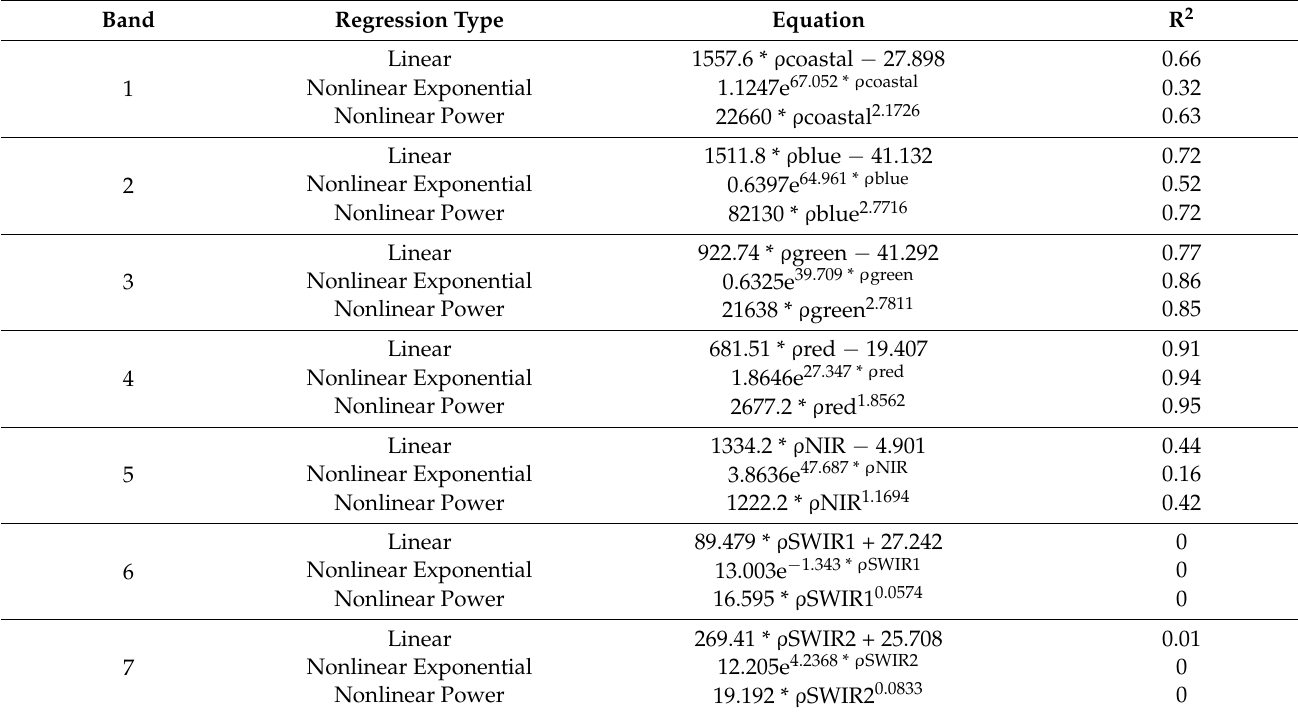
Table 3. Linear, exponential, and power regression equations obtained by comparing in situ turbidity measurements and sensor reflectance